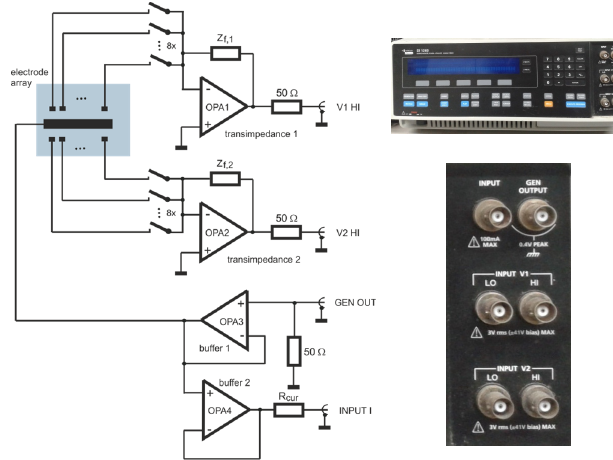
Fig.2: Principle schematic of the true difference frontend (left panel) for Solartron S-1260 (right panel). Each trapping and reference electrode was connected with a relay to the input of the operational amplifiers (OPA1 / OPA2). The shield of the voltage monitors is connected to ground. The measurement channel is connected to the cell trapping electrode.